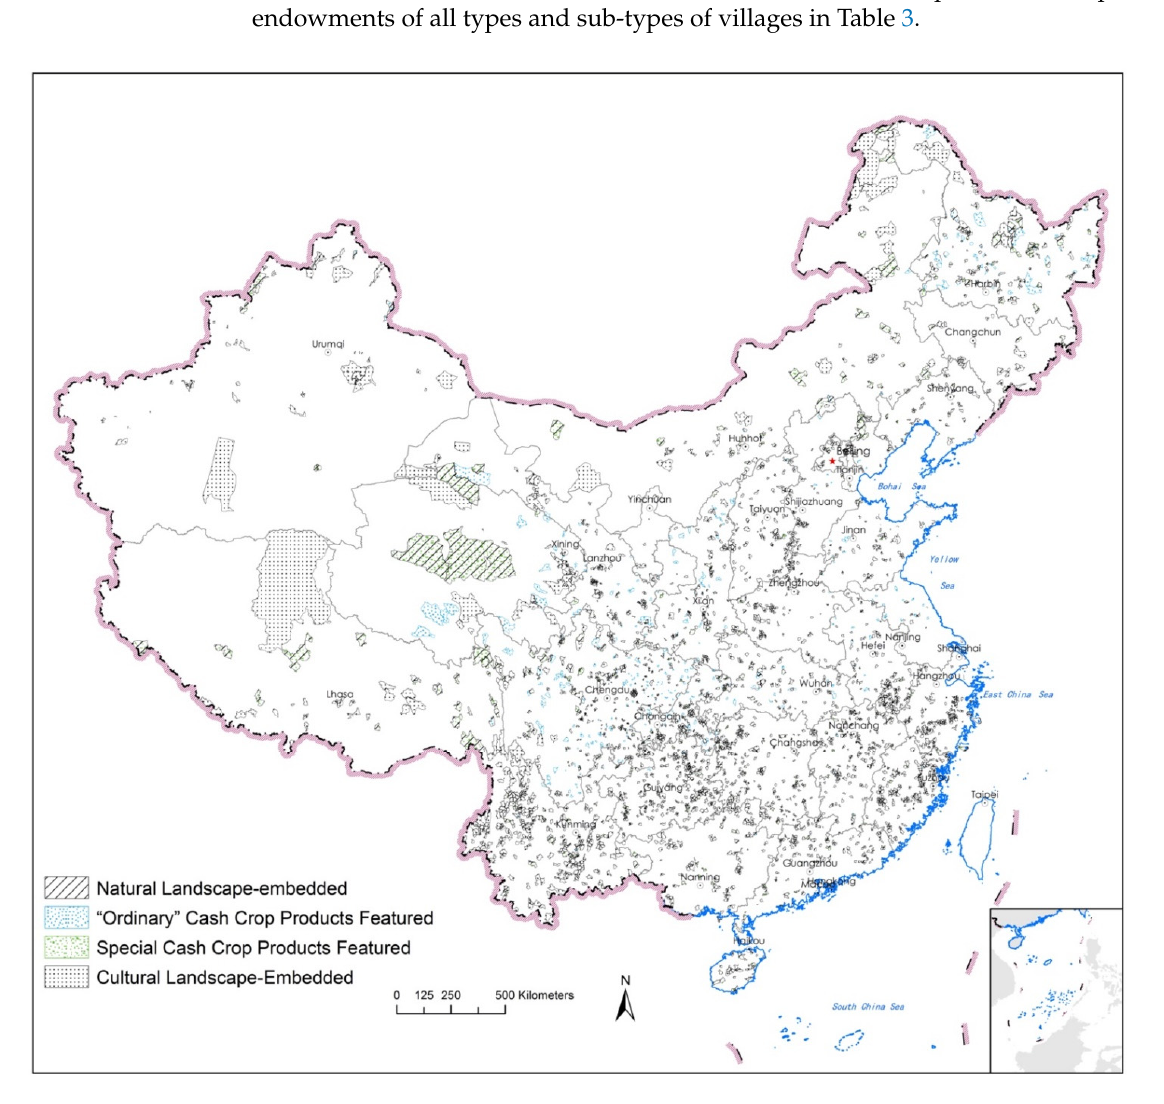
Figure 6. Distribution of the Four Sub-types of the “Endowment-based Development” Type of Villages. Table 3. Rural Revitalization Types and